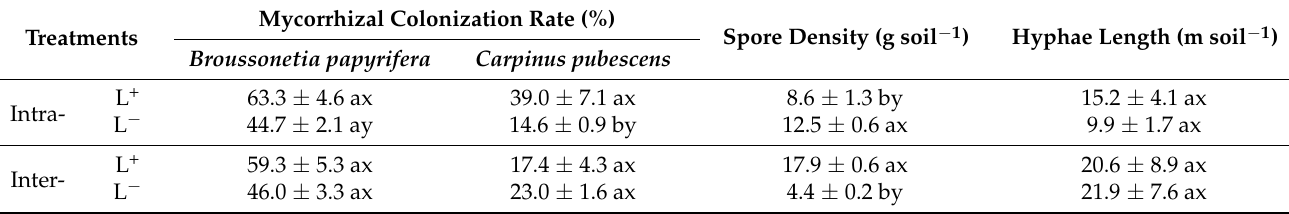
Table 1. The root mycorrhizal colonization of Broussonetia papyrifera and Carpinus pubescens , the spore density and the hyphal length through the treatments of competition pattern and with or without litter addition under AM fungus inoculation.